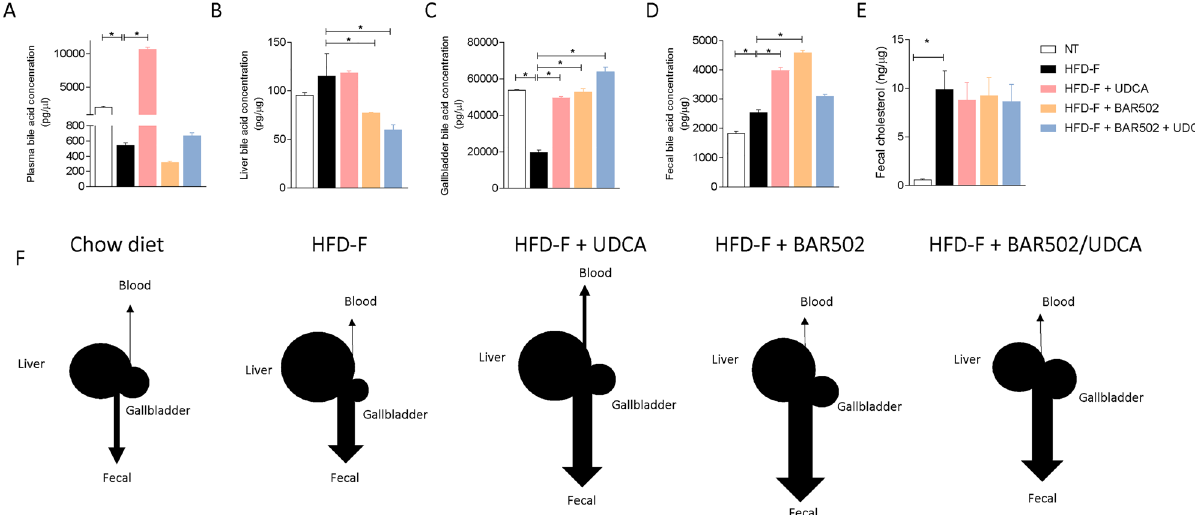
Figure 8. Bile acids concentration in: ( A ) Serum, ( B ) Liver, ( C ) Gallbladder and ( D ) Feces. ( E ) Cholesterol content in the stool. Each result is the mean ± SEM of 7–11 mice per group. *p ≤ 0.05. ( F ) Representative image of the bile acids content in cholesterol excretion in each experimental group.